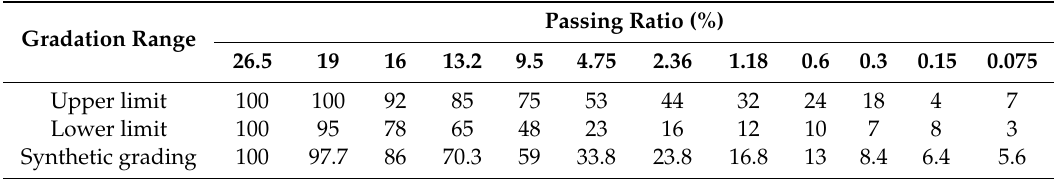
Table 6. Grading composition and technical requirements of AC-20 asphalt mixture.